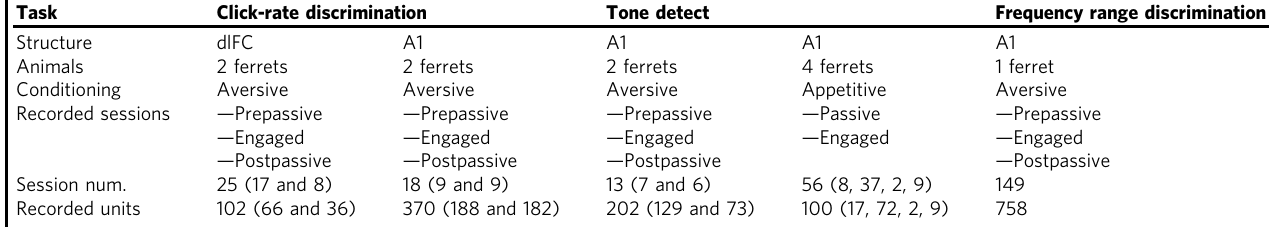
Table 1 Data summary across behavioral tasks Task Click-rate discrimination Tone detect